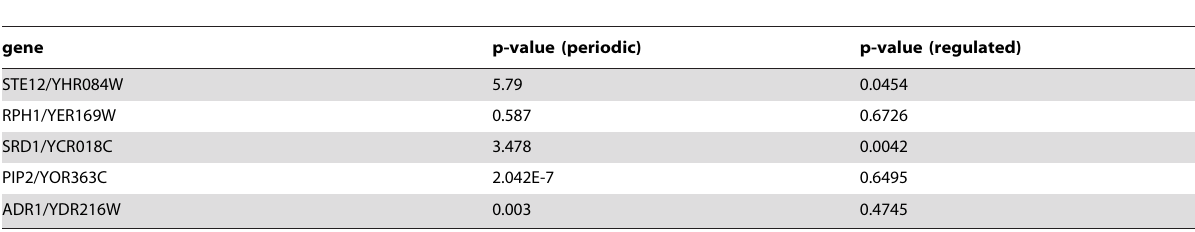
Table 4. P-values for periodicity and for regulation according to the evaluation of Cyclebase [30].